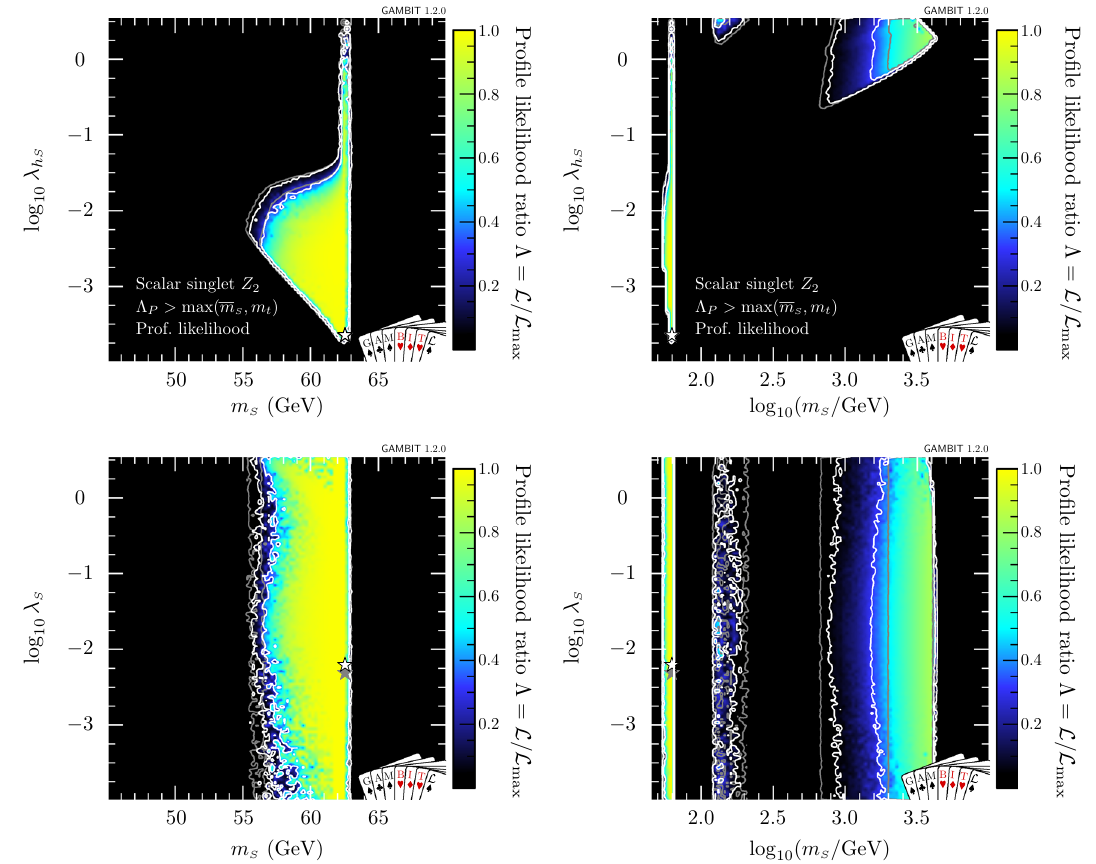
Fig. 2 Profile likelihoods for the Z 2 scalar singlet model, with the requirement that Λ P > max ( m S , m t ) only. Results are shown in the m S – λ h S ( top ) and m S – λ S ( bottom ) planes. Left panels show a zoomed- in view of the resonance region; right panels show the full mass range.